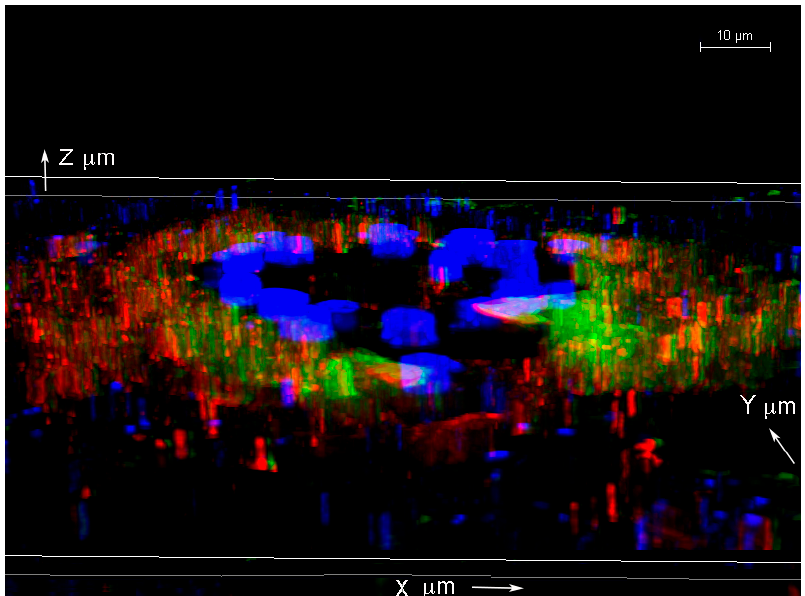
Figure 5. Three-dimensional analysis of biofilm form of B. burgdorferi via confocal microscopy in an infected biopsy tissue inoculated with 1 × 10 7 spirochetes and cultured in BSK-H 6% RS for 14 days. Confocal microscopy analyses of the tissue section performed using merged individual z-stacks to form a composite 3D image from three confocal microscopy channels alginate (red staining), B. burgdorferi (green staining), and DAPI (blue staining); 1000× magnification. Scale bar: 10 μ m.